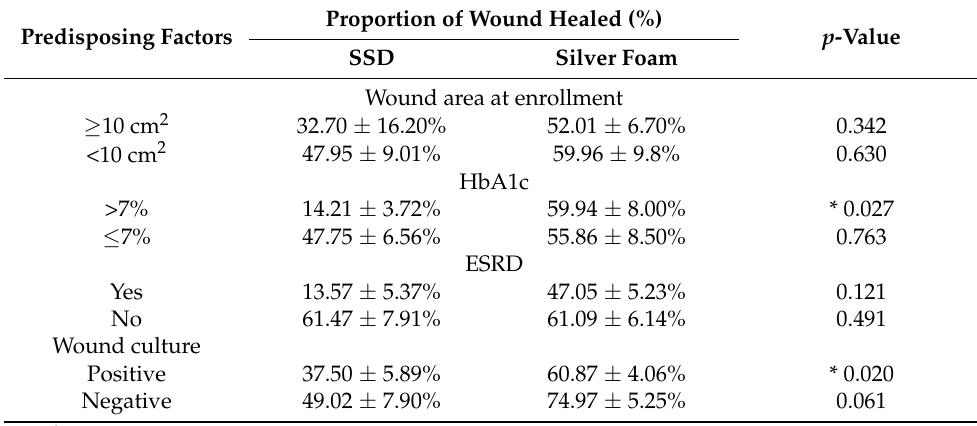
Table 3. Analysis of the predisposing factors and wound healing in both groups. Predisposing